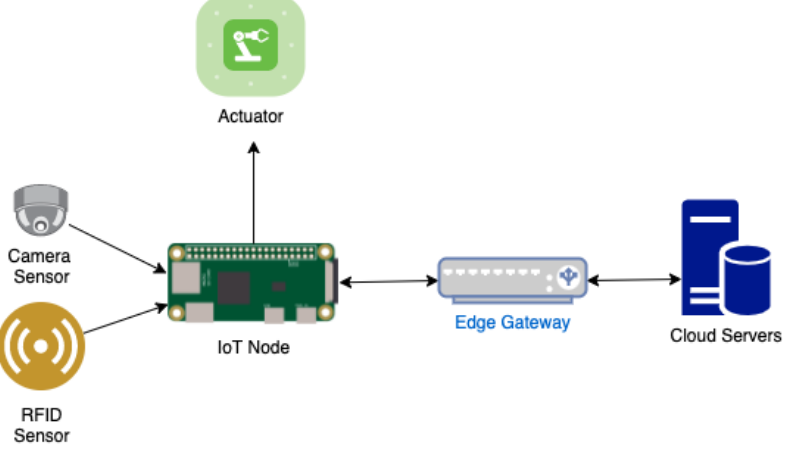
Figure 1. Edge Computing